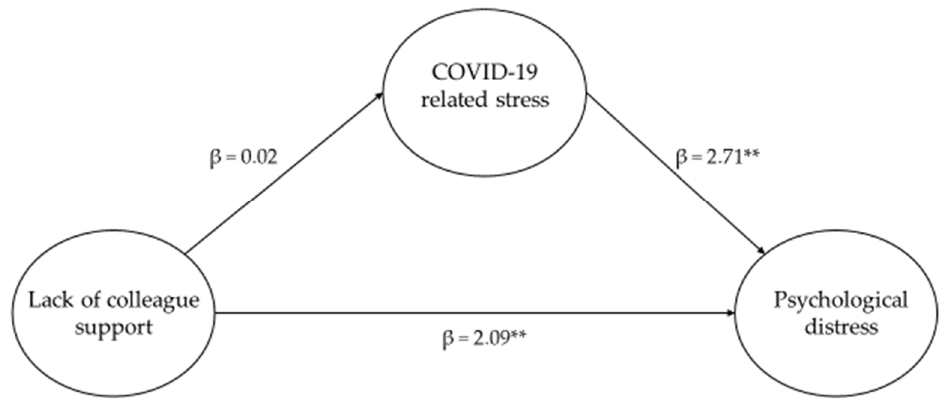
Figure 2. COVID-19-related post-traumatic stress as a mediator between lack of colleague support and psychological distress. Note: N = 275, ** p < 0.01.